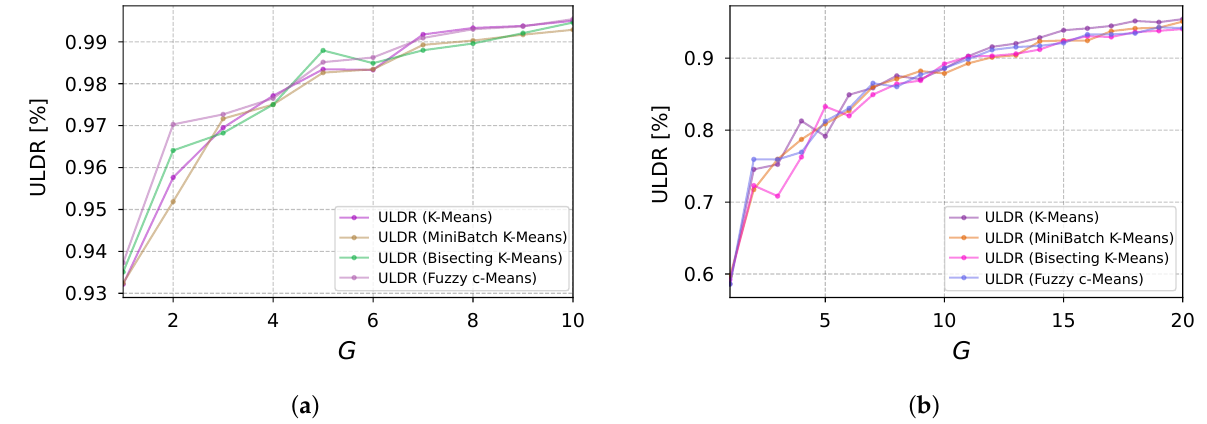
Figure 9. ULDR evolution as a function of the number of GWs obtained by the method considering ( a ) Scenario 1, and ( b ) Scenario 2.